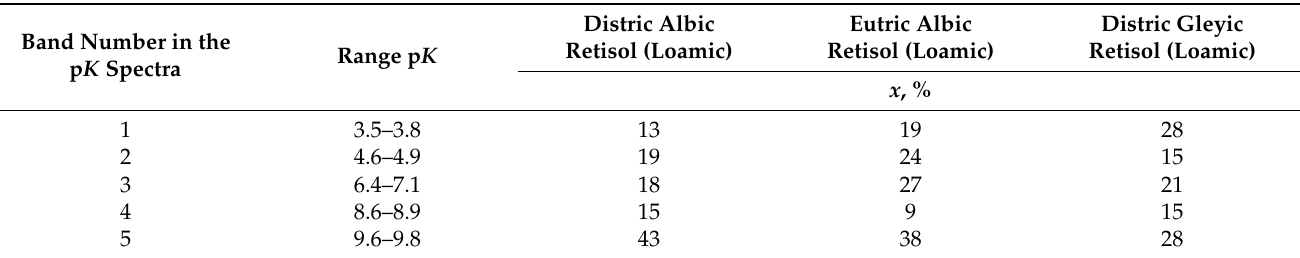
Table 5. Molar fractions ( x ) of acid groups in scour waters from their total amount contained in the extracts and scour water, according to the ranges of p K .